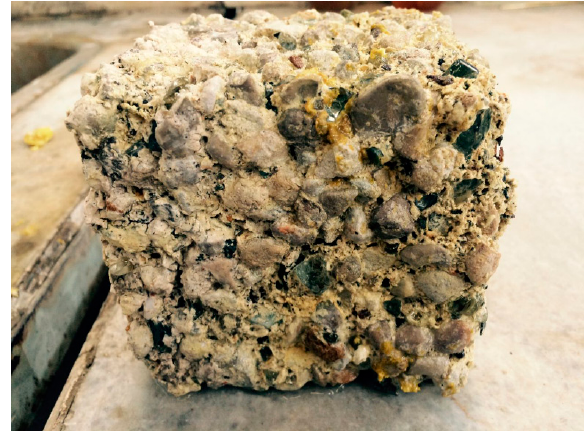
Figure 6. Physical appearance of typical samples in 5% sulphuric acid solution.